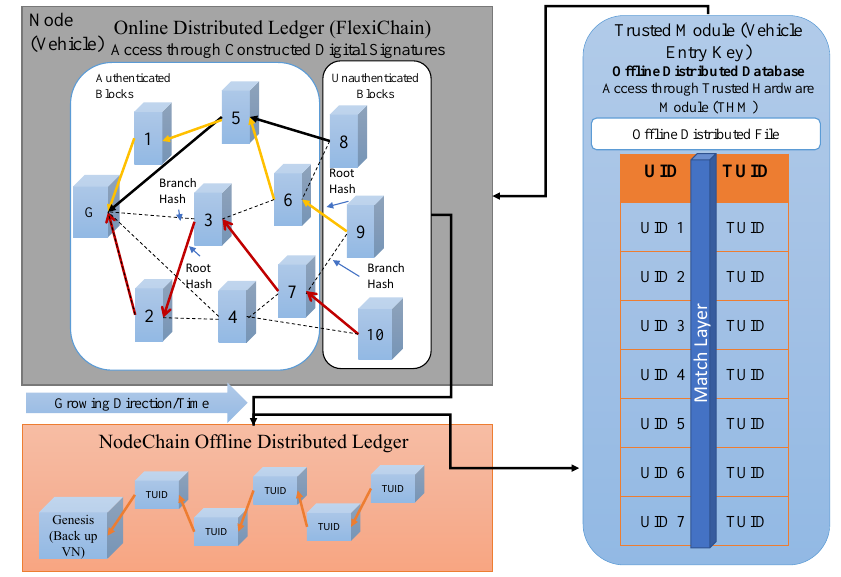
Figure 6. NodeChain Offline